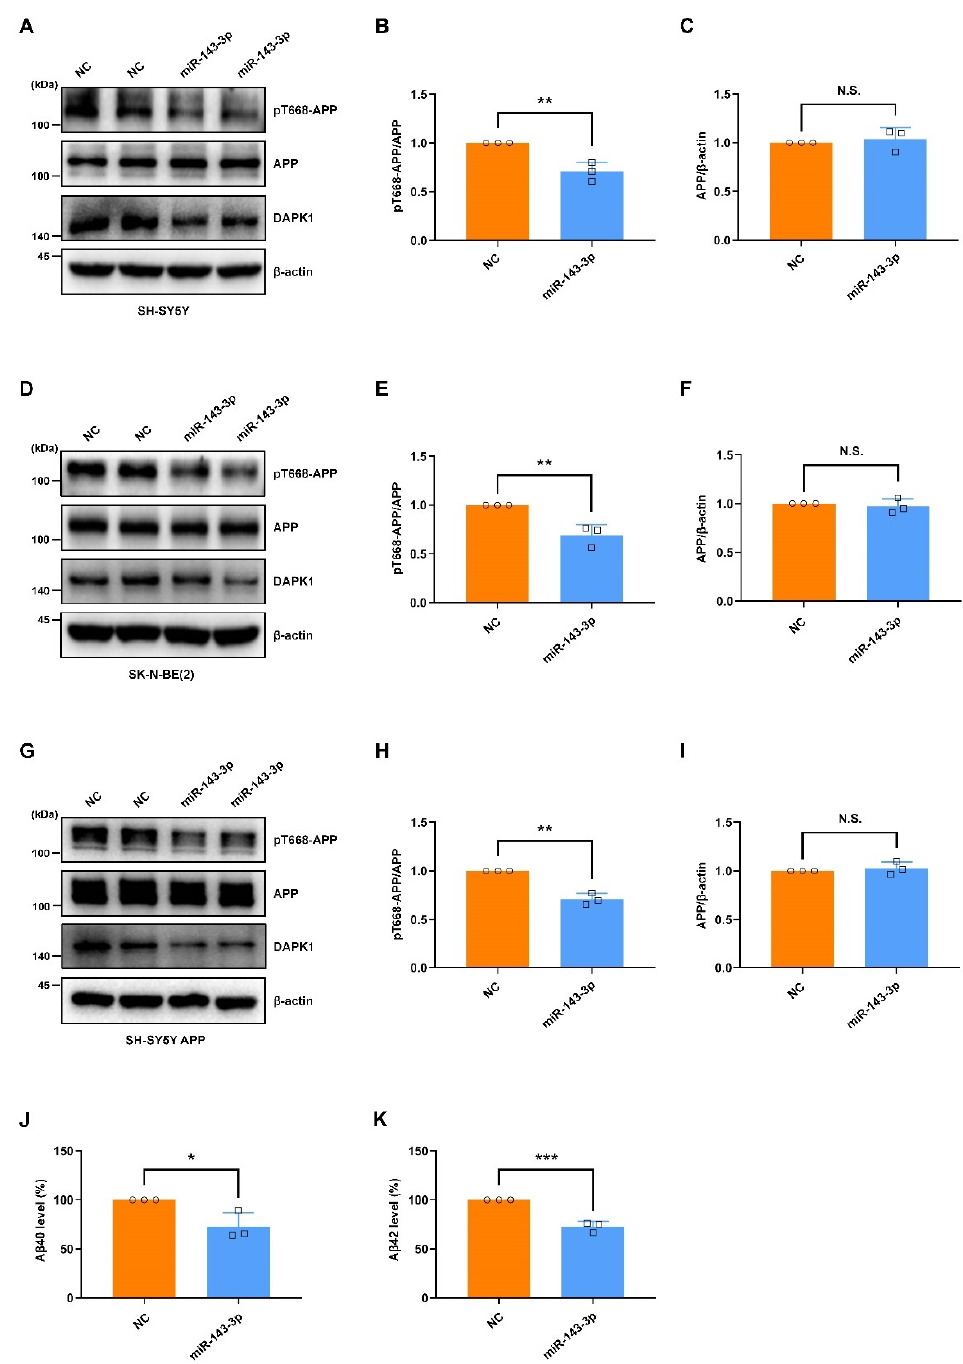
effects of hsa-miR-143-3p on tau phosphorylation, APP phosphorylation, and both human A β 40 and A β 42 secretion.